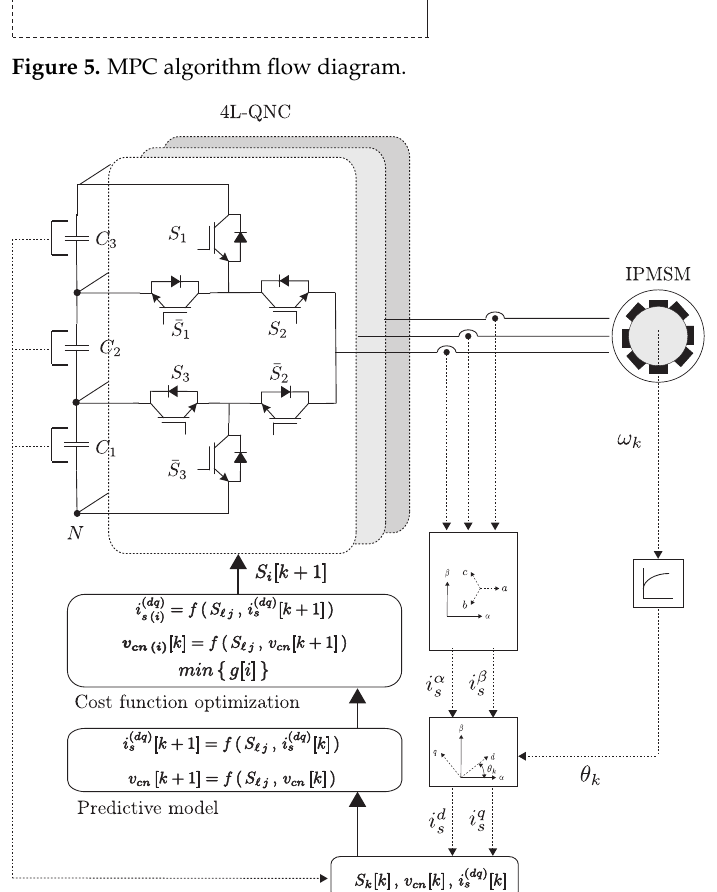
Figure 6. MPC implementation